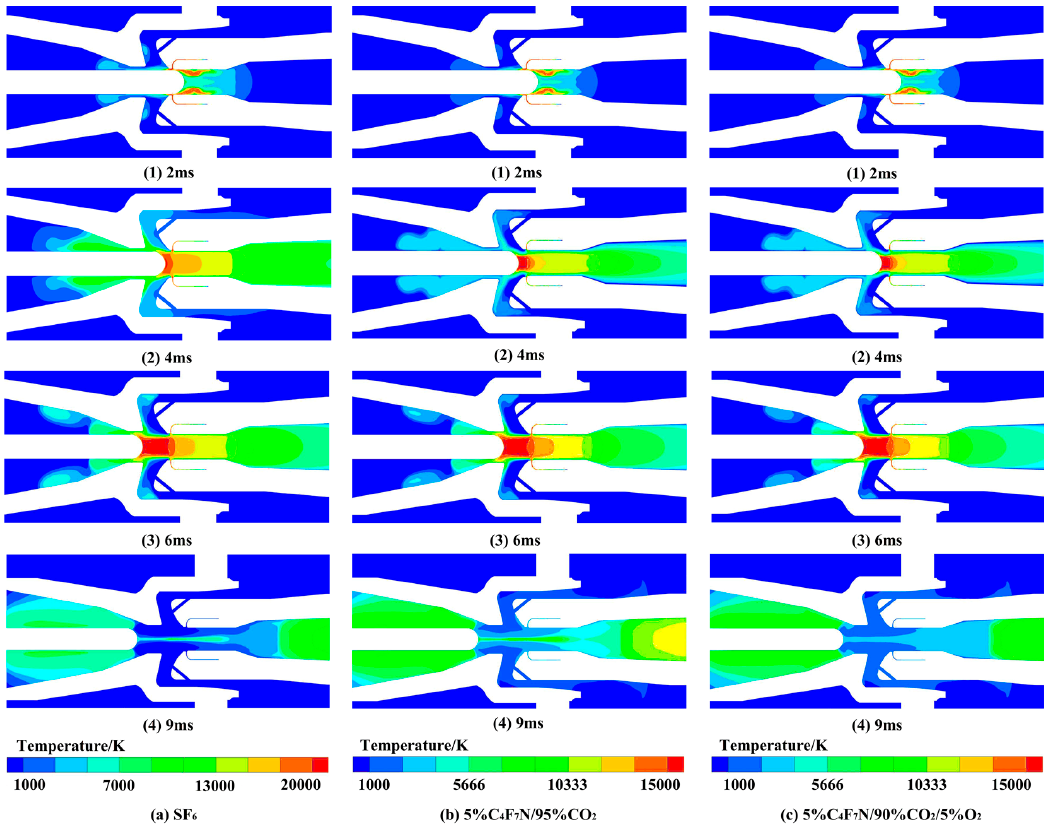
Figure 2. Arc temperature dynamic distribution.